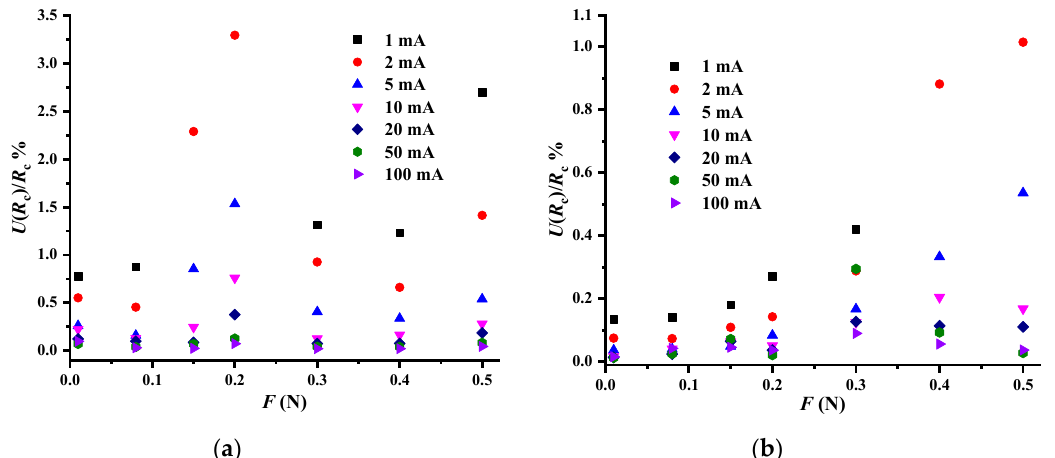
Figure 12. The variation of the expanded uncertainty of the contact resistance with varied contact pressure. ( a ) Gold-plated rivet. ( b ) AgCdO rivet.